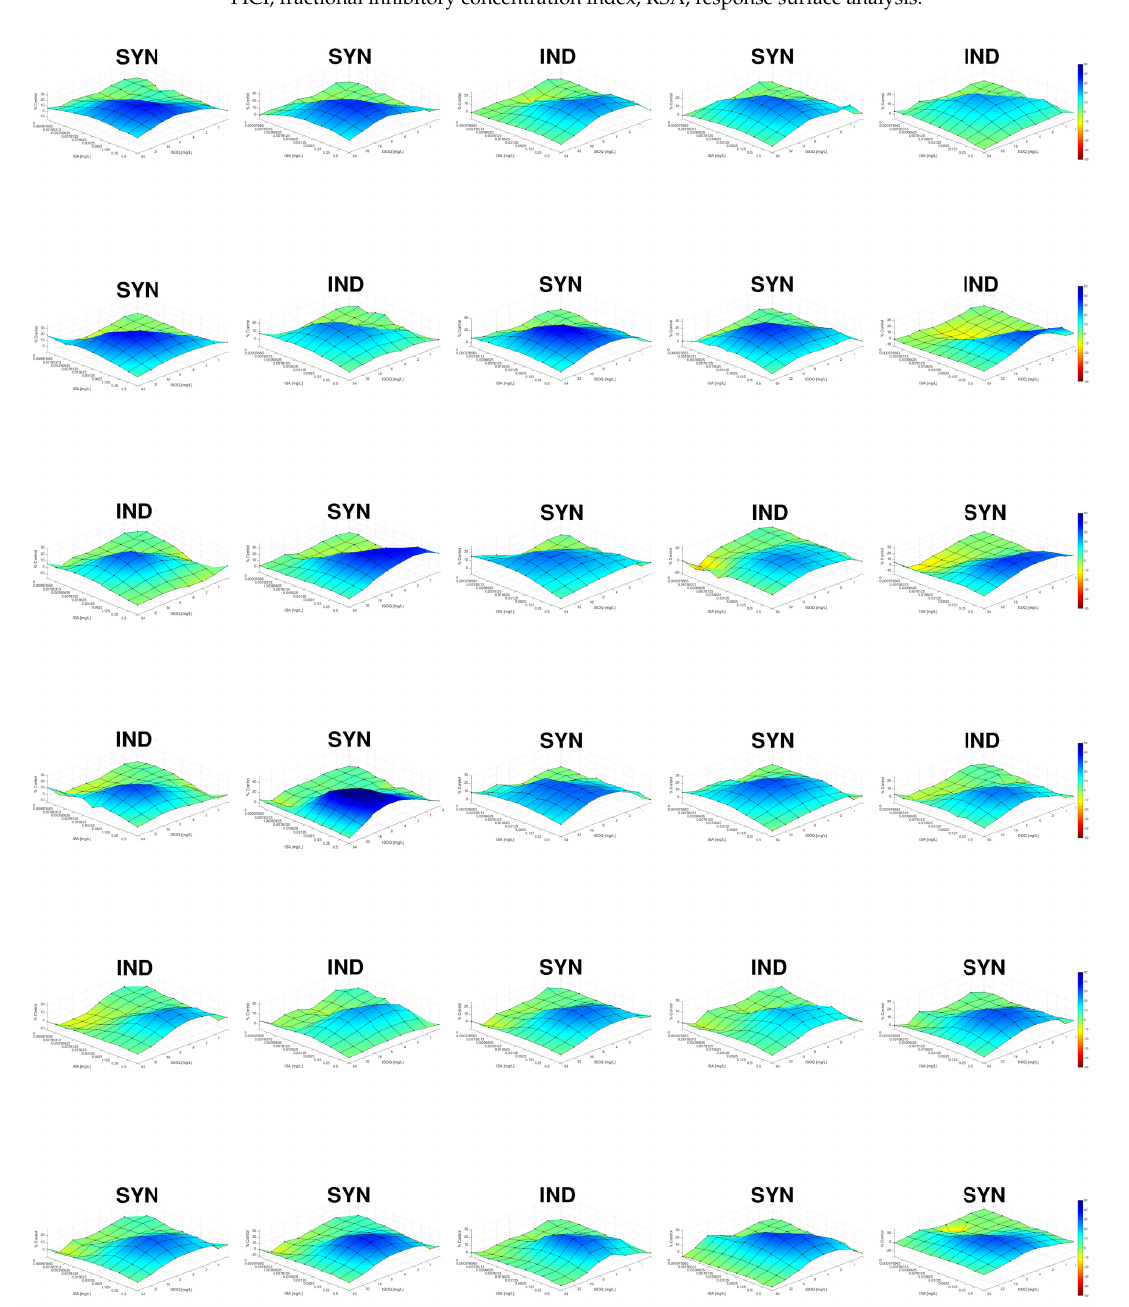
Figure 1. Synergy distribution for the combination of isavuconazole with isoquercitrin against all C. glabrata strains tested. Always from the left to the right, first row: V2105272, V2105282, N2101711, V2105636, DSM 70614; second row: U2105834, V2105576, N2102530, U2106503, U2106602; third